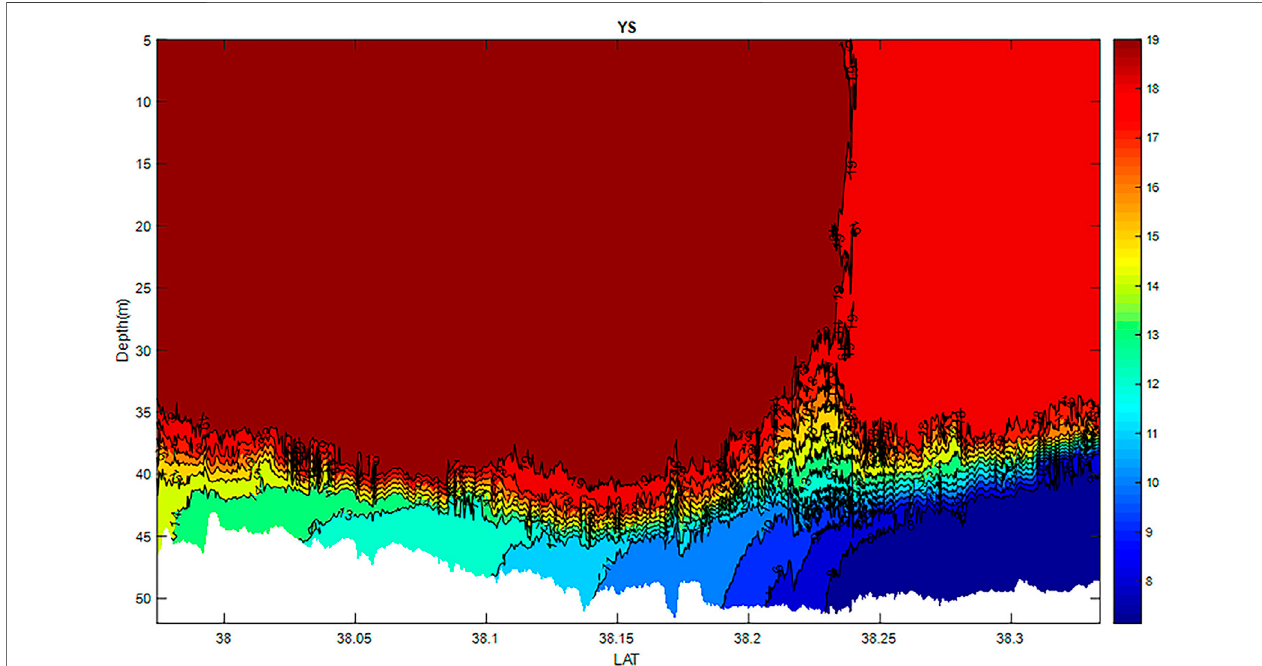
FIGURE 2 | Temperature-depth pro fi le of North Yellow Sea of China.